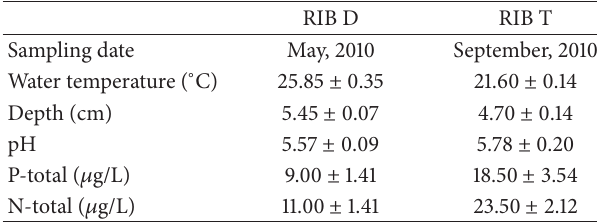
Table 1: Comparison of physicochemical properties of freshwater lake sediments from replicates of the dry season (RIB D) and of the transition period between the dry and rainy seasons (RIB